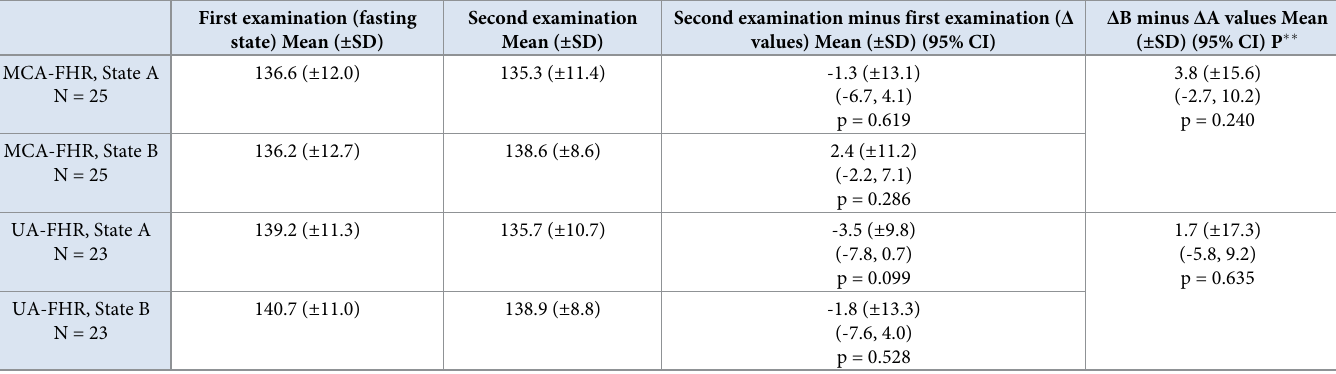
Table 3. Fetal heart rate in the middle cerebral artery and umbilical artery in the first and the second examination in state A and state B. First examination (fasting state) Mean ( ± SD)